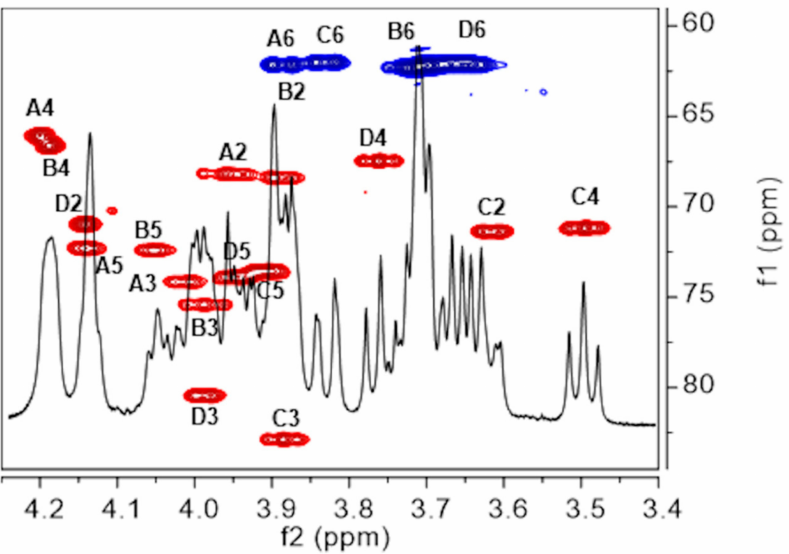
Figure 2. Saccharide ring region overlay of 1 H NMR spectrum and gHSQCAD plot recorded at 50 ◦ C of Epol H111-INS extracted from the biofilm of B. cenocepacia . Proton / carbon cross peaks have been labelled according to the corresponding residue ( A to D ), as in Table 1. Methine cross peaks are shown in red and methylene in